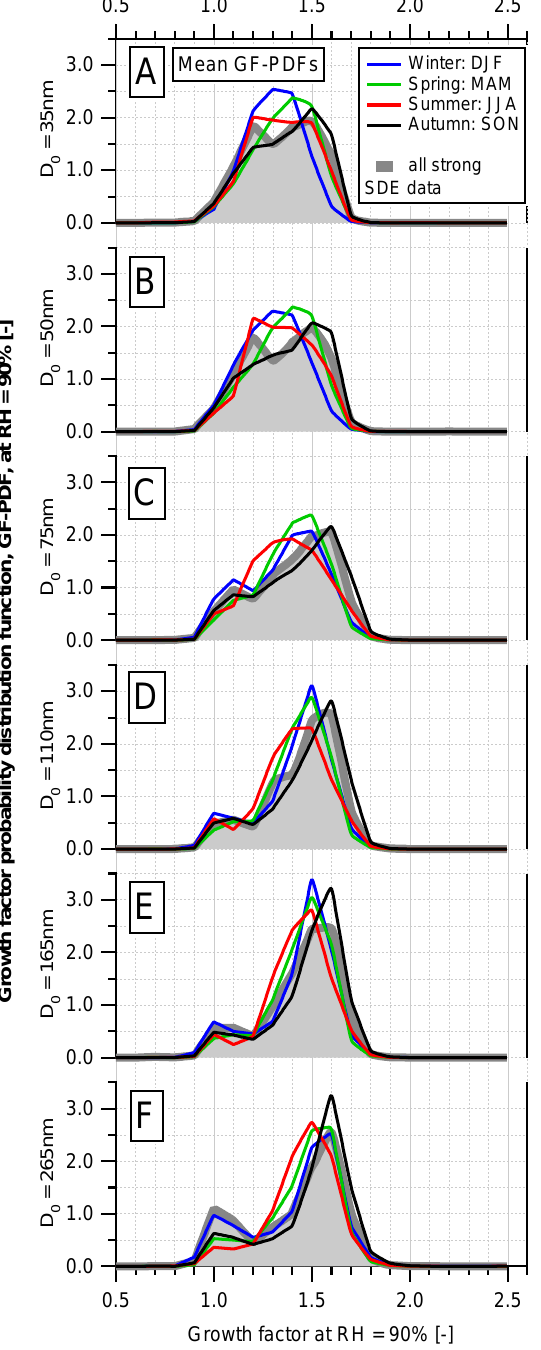
Fig. 2. Mean GF-PDFs for different dry sizes split by season as well as for strong SDE data from all seasons.